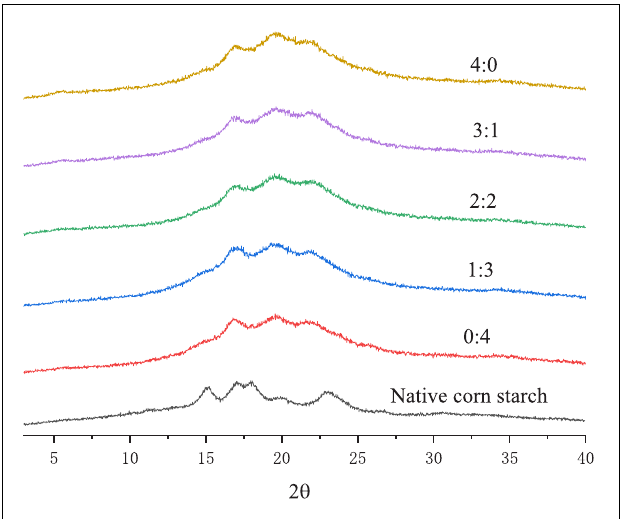
FIGURE 4 | XRD of corn starch-based films supplemented with GLY and ERY (4:0, 3:1, 2:2, 1:3, and 0:4).